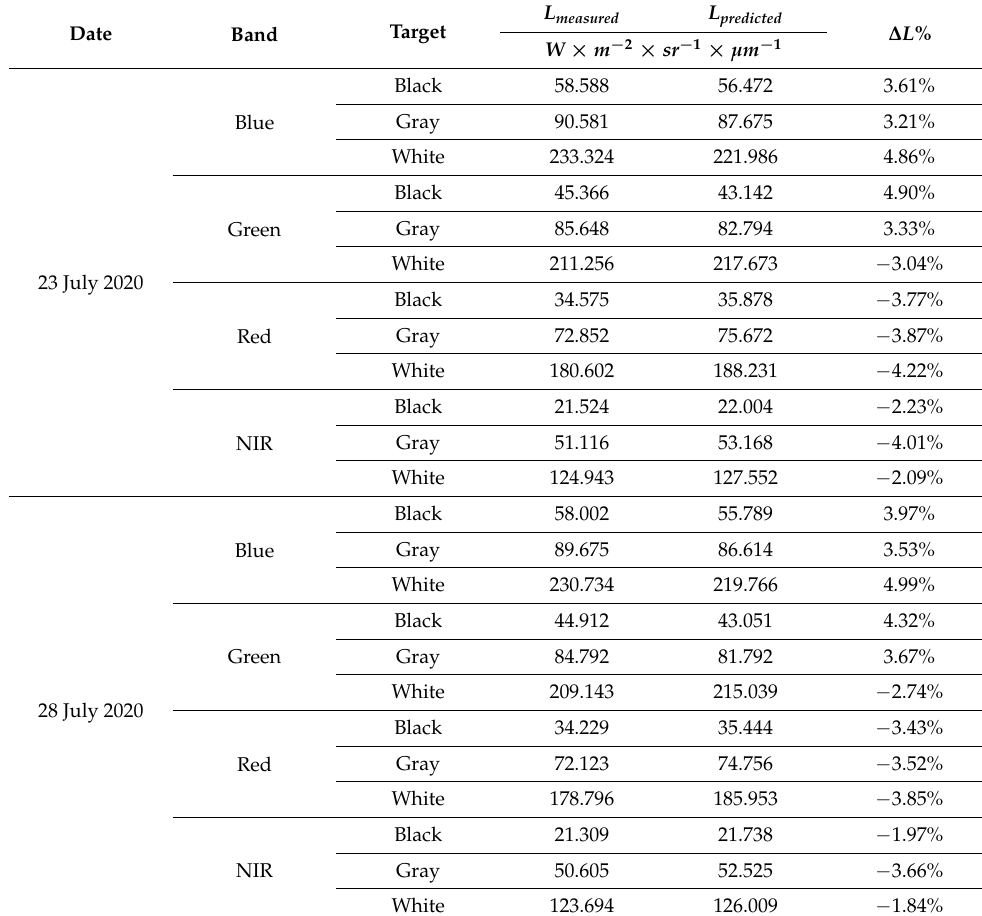
Table 5. The absolute radiometric calibration result of the GF-7 satellite at the Baotou site on 23 and